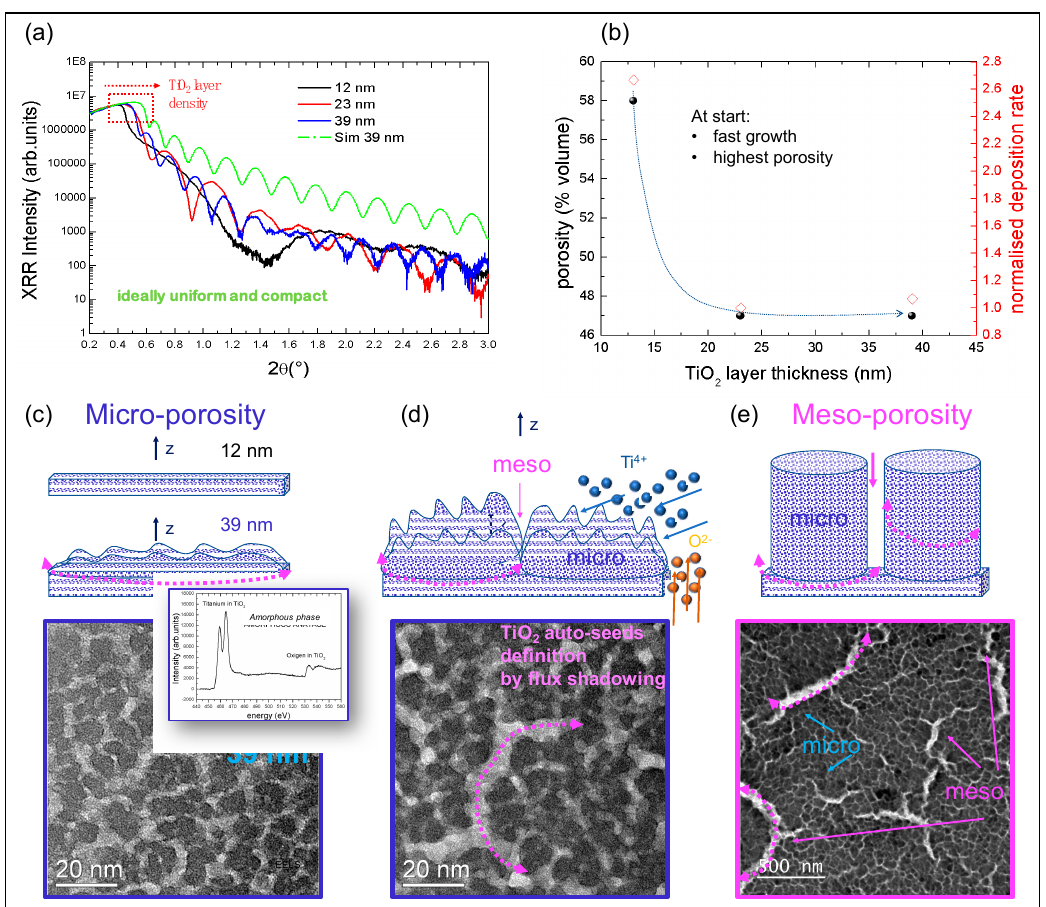
Figure 1. ( a ) X-ray reflectivity (XRR) profile of starting layers of different thickness, compared to the ideal case of a compact flat amorphous TiO 2 layer in the anatase polymorph. ( b ) porosity and deposition rate as a function of the grown thickness. Plane-view transmission electron microscopy (TEM) analyses of ( c ) a layer containing auto-seeds (39 nm); ( d ) a thicker layer with meso-pores starting to be defined; ( e ) a final layer (400 nm) with meso- and micro-porosity defined on a large scale (cross-section in Figure 2). The schematic provides the overall scenario during the initial growth, starting from the first minutes (transient) wherein a matrix of small TiO 2 grains and micro-pores are equally distributed and originated in a Thornton-like regime (high Ar pressure). During further growth, a network of larger TiO 2 auto-seeds gives rise to grazing incidence geometry with local oxidation (gig-lox) columns separated by meso-pores due to shadowing under rotation (steady state growth).